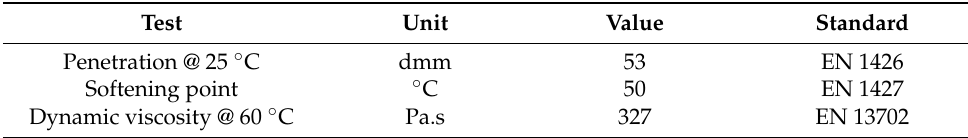
Table 1. Rheological properties of neat bitumen.